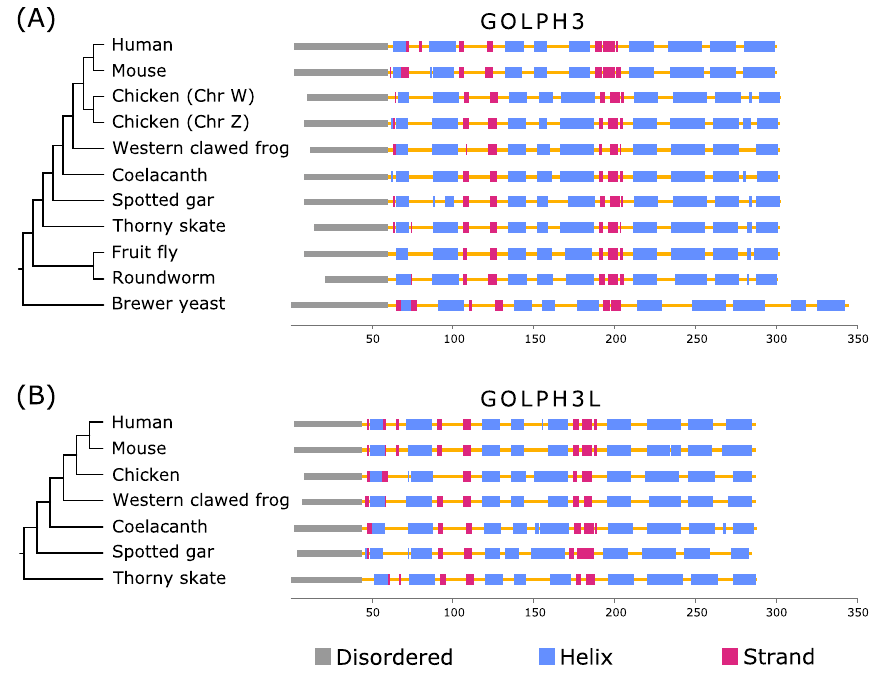
Figure 6. Secondary structure and disordered region predictions of GOLPH3 ( A ) and GOLPH3L ( B ) in human ( Homo sapiens ), mouse ( Mus musculus ), chicken ( Gallus gallus ), Western clawed frog ( Xenopus tropicalis ), coelacanth ( Latimeria chalumnae ), spotted gar ( Lepisosteus oculatus ), thorny skate ( Amblyraja radiata ), fruit fly ( Drosophila melanogaster ), roundworm ( Caenorhabditis elegans ) and brewer yeast ( Saccharomyces cerevisiae